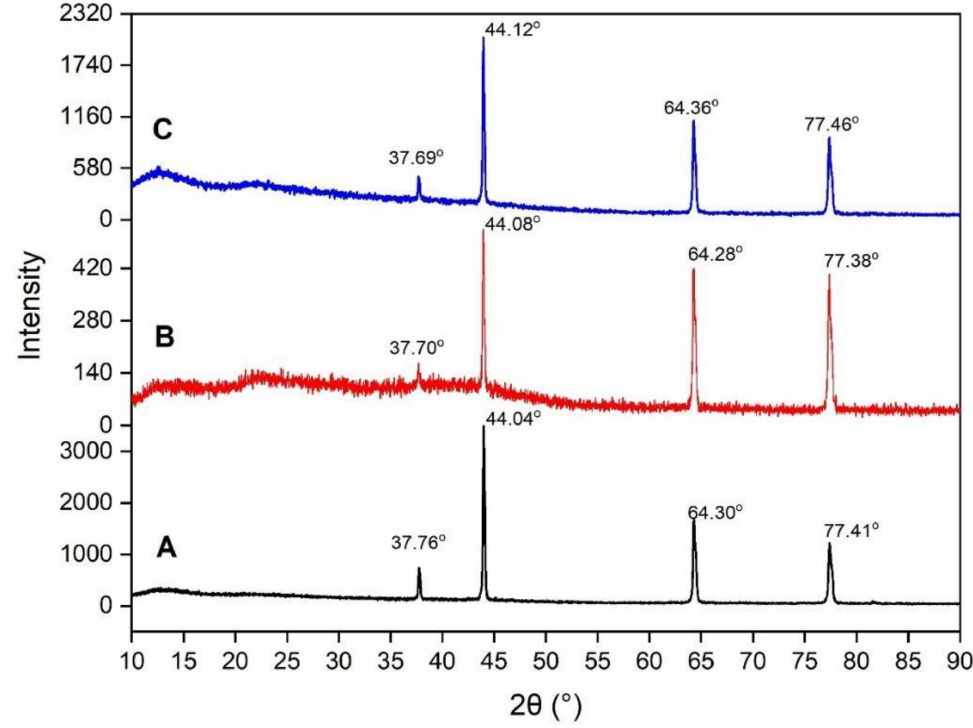
Figure 5. The X-ray diffraction (XRD) pattern of ( A ) control film (SA); ( B ) SA/KC film; ( C ) Crosslinked SA/KC